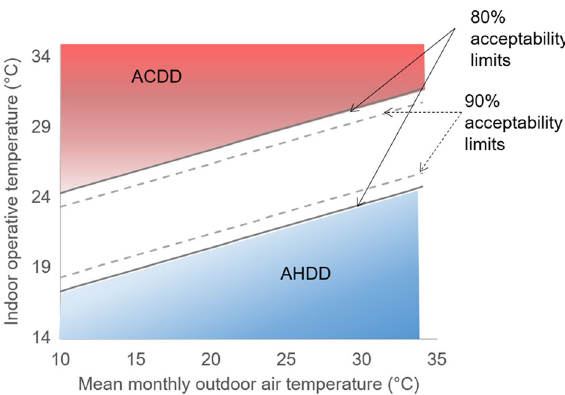
Figure 3. Representation of ACDD and AHDD based on Adaptive Thermal comfort model, ASHRAE 55: The plot shown in the figure represents the Adaptive thermal comfort model defined in ASHRAE 55. Solid line indicates 80% acceptability limits and dotted line indicates 90% acceptability limits. Figure depicts the method adopted for calculating Adaptive Heating Degree Days (AHDD) and Adaptive Cooling Degree Days (ACDD). Indoor operative temperatures falling above or below the 80% acceptability limits multiplied by the duration for which the temperature lasts are used to calculate ACDD and AHDD, respectively. Duration for which the indoor operative temperatures fall above the 80% acceptability limit will require active cooling to attain comfort. Similarly, duration for which the indoor operative temperatures fall below the 80% acceptability limit will require active heating for